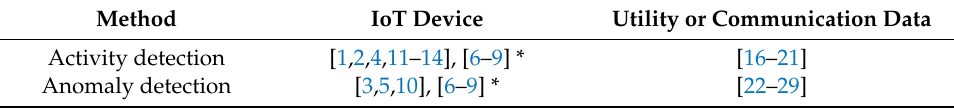
Table 1. Comparison of methods for implementing care services.